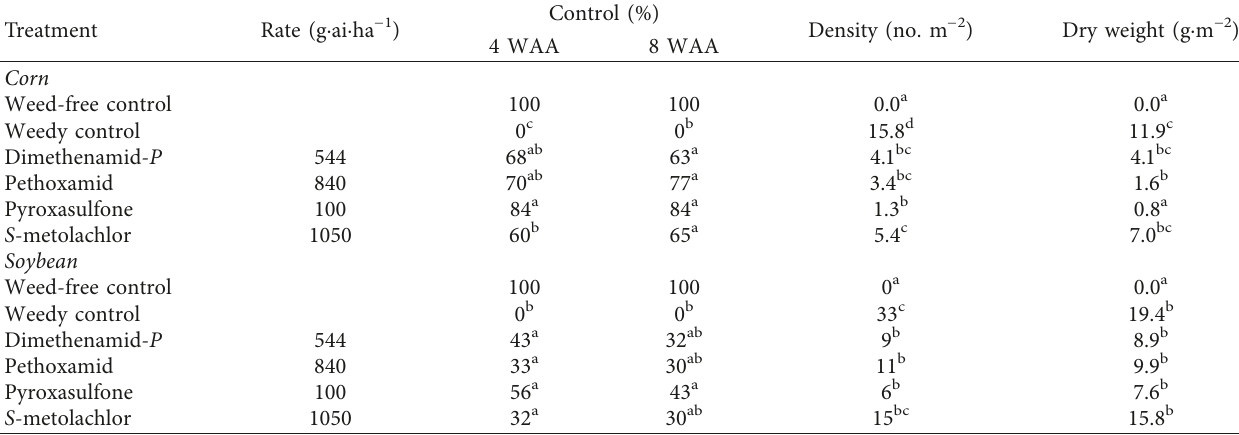
Table 4: Control, density, and dry weight of common lambsquarters in corn and soybean treated with VLCFA inhibitor herbicides, applied preemergence (PRE), near Exeter in 2015–2017 and Ridgetown in 2017 a . Treatment